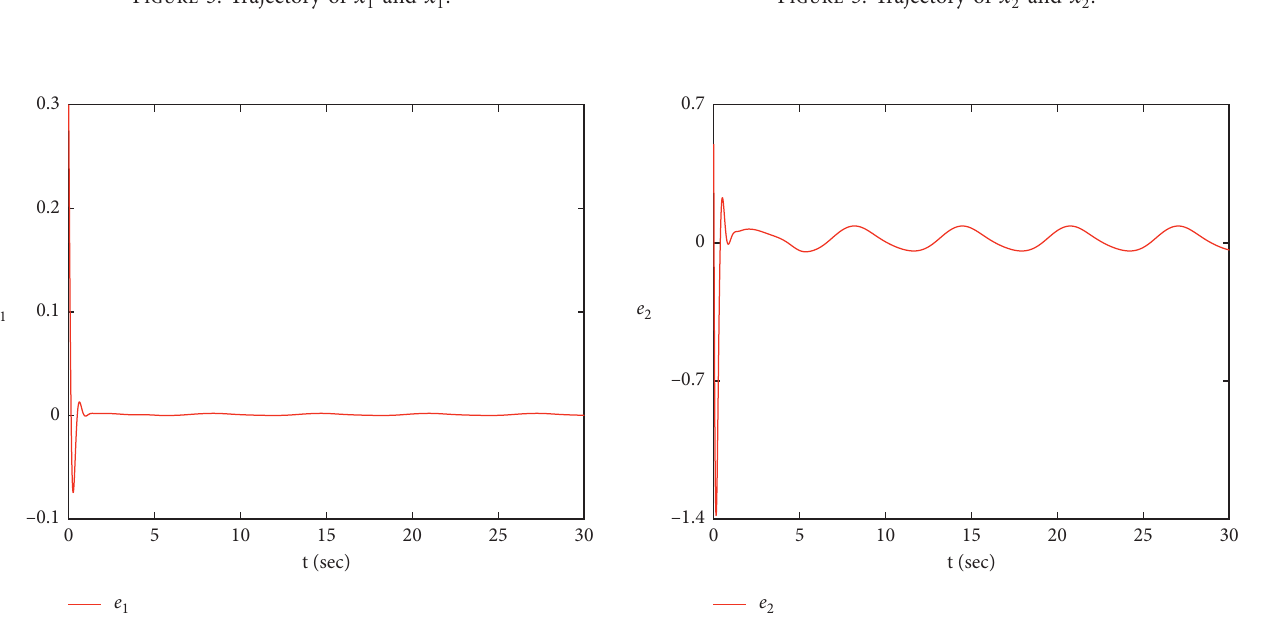
Figure 3: Trajectory of x